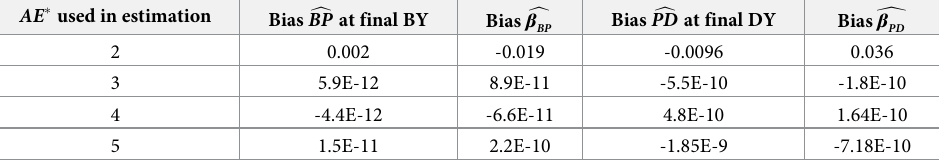
Table 3. Comparison of the effect of the choice of assumed AE � vs. true value of AE = 3, with one homogeneous group of cases.